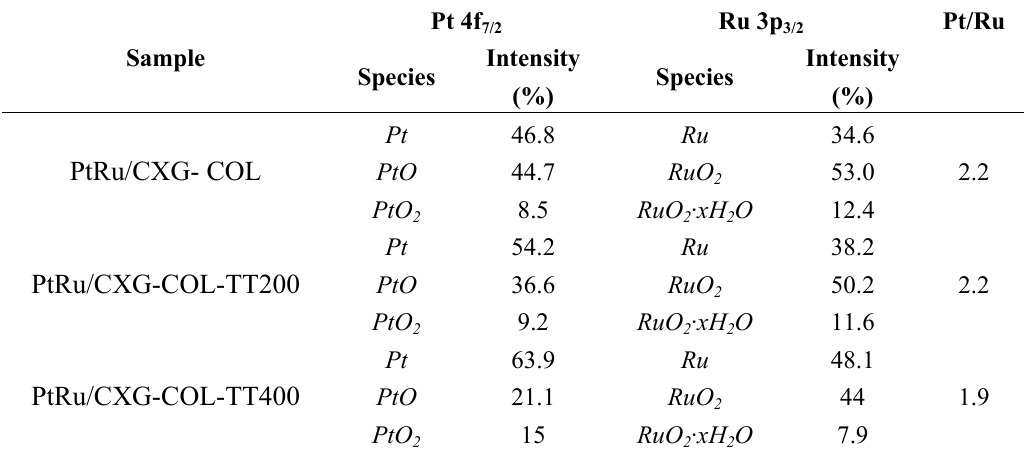
Table 3. Binding energies of the Pt 4f determined by